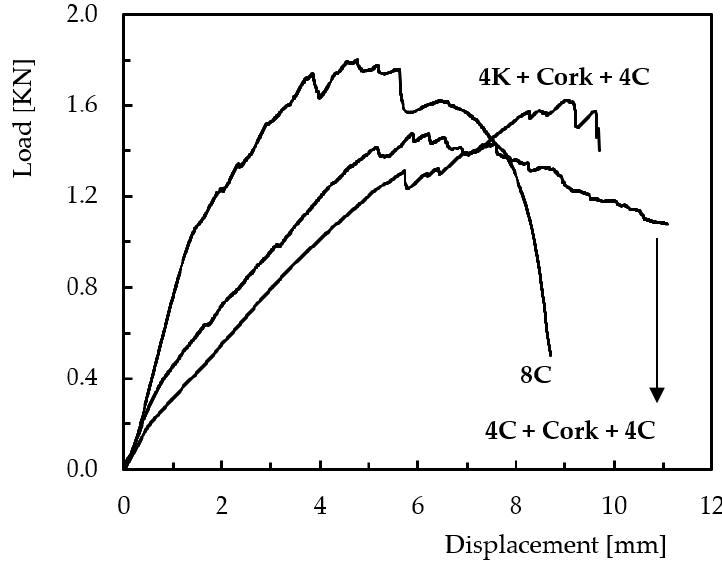
Figure 4. Cork core effect and hybridization effect on the compressive curves.